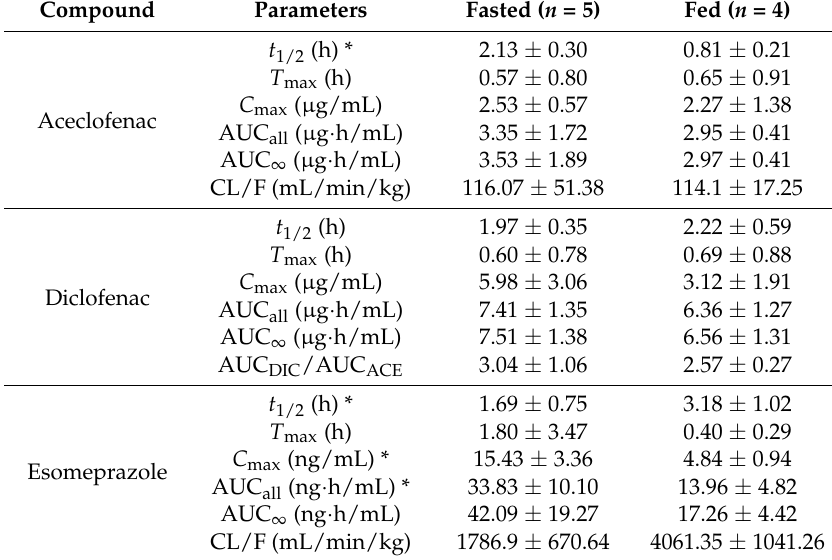
Table 3. Non-compartmental pharmacokinetic parameters of aceclofenac, diclofenac, and esomeprazole obtained after oral administration of aceclofenac (20 mg/kg) and esomeprazole (4 mg/kg) to rats under fasted and fed